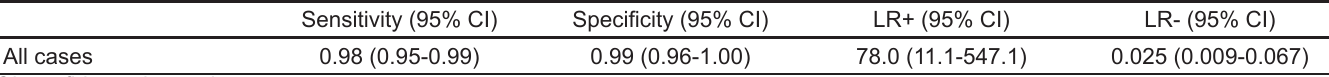
Table 2. Cumulative sensitivity, specificity, positive and negative likelihood ratios for transesophageal echocardiography during simulated cardiac arrests, across all